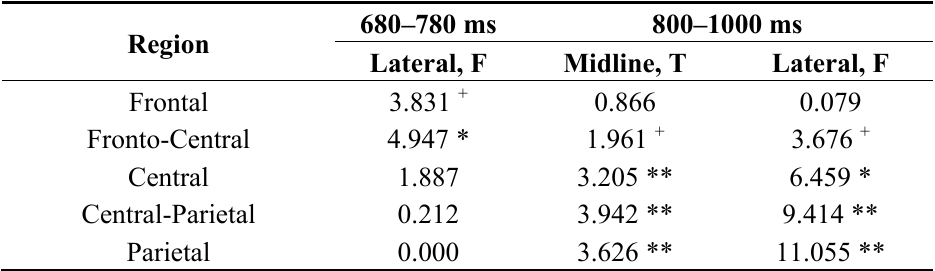
Table 10. First letter, F -values for the effect of order, for each anteriority region, 680–780 ms (P2) and 800–1000 ms